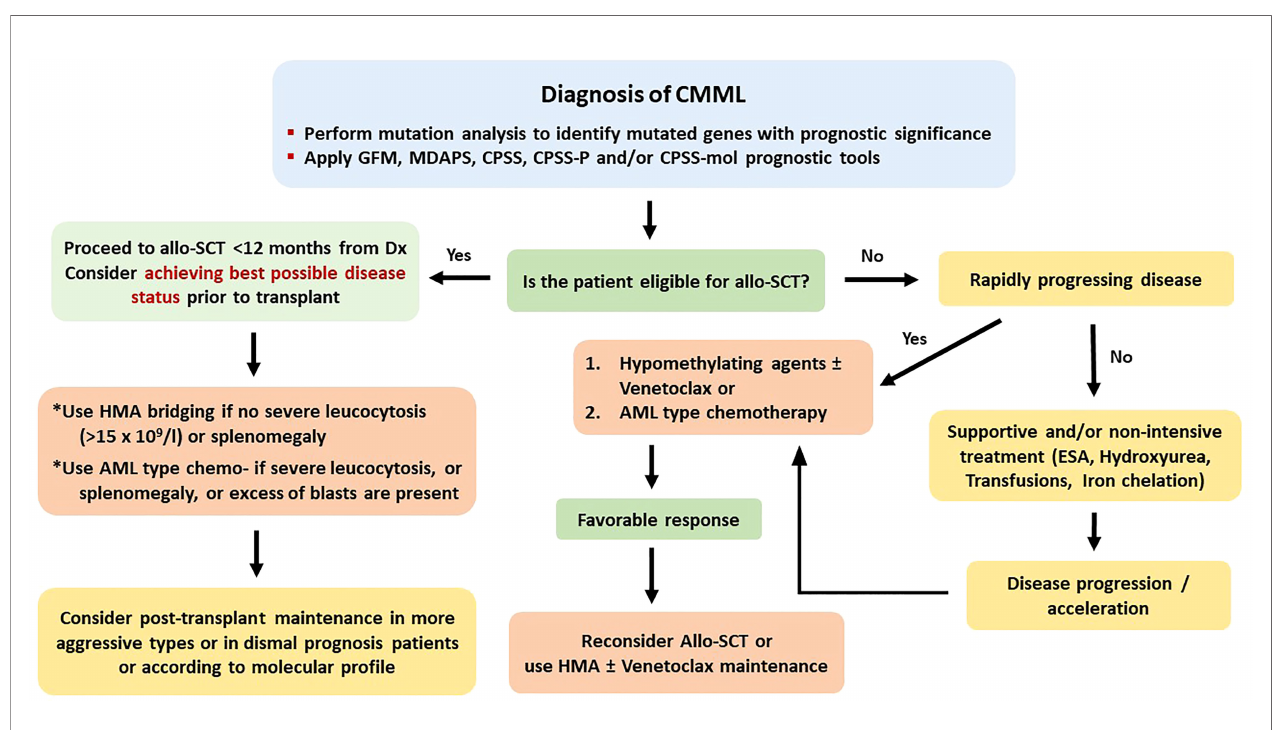
FIGURE 1 | Recommended treatment algorithm for patients with chronic myelomonocytic leukemia.